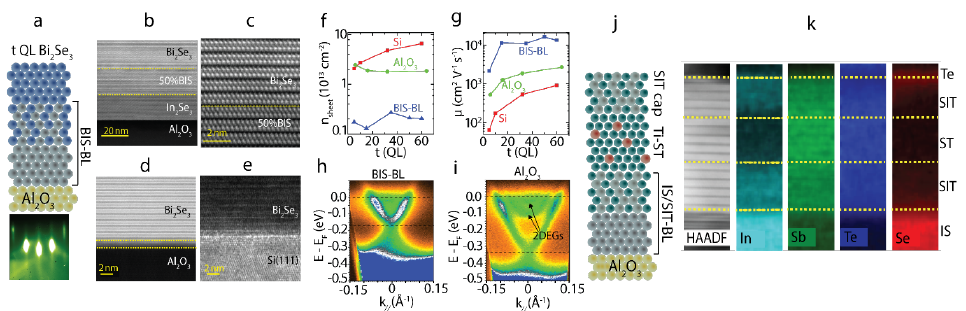
Se and Sb Te films with ultralow Fermi lev- Figure 1: Interface-engineered Bi 2 3 2 3 els . a, Cartoon of a buffer-layer-based Bi Se film where the buffer-layer (BIS-BL) is 2 3 composed of a 20 QL-thick In Se and a 20 QL-thick (Bi In ) Se (for growth de- 2 3 0.5 0.5 2 3 tails see ref. [ 57 ] ). The RHEED image of Bi Se film (bottom panel) shows high 2 3 quality 2D growth. b, and c, High angle annular dark-field scanning tunneling electron microscopy (HAADF-STEM) image of Bi Se grown on BIS-BL shows an 2 3 atomically-sharp interface between Bi Se and BIS-BL (50%BIS is a short form of 2 3 (Bi In ) Se ), while d, Bi Se grown directly on Al O has clearly disordered in- 0.5 0.5 2 3 2 3 2 3 terface. e, TEM image of Bi Se grown on Si(111) (from ref. [ 40 ] ) also shows a 2 3 hazy interface. Comparison of f, sheet carrier densities ( n ) and g, Hall mobilities sheet ( µ ) of Bi Se films grown on BIS-BL, Al O (0001) and Si (111) for different film 2 3 2 3 thicknesses. ARPES of Bi Se grown on h, BIS-BL shows the bulk-insulating nature 2 3 of the film with the surface Fermi level in the bulk gap and i, Al O (0001), where 2 3 the surface Fermi level is located above the bottom of the conduction band and the 2DEG originating from downward band bending is marked. (a), (b), (c), (d), (f), (g), (h), and (i) are adapted from ref. [ 57 ] . j, Schematic of the buffer-layer-based Sb Te 2 3 film structure. The buffer-layer (IS / SIT-BL) consists of 20 QL In Se and 15 QL- 2 3 thick (Sb In ) Te BL as a template for the successive layer of ultra-low carrier 0.65 0.35 2 3 density Ti-doped Sb Te . The film is capped by 15 QL (Sb In ) Te providing 2 3 0.65 0.35 2 3 a symmetric condition for top and bottom surfaces of the Sb Te film. k, The first 2 3 / 5 QL (Sb / 5 QL Sb / 5 QL panel shows HAADF-STEM for In Se In ) Te Te 2 3 0.65 0.35 2 3 2 3 (Sb In ) Te with an additional 10 nm Te capping for further protection against 0.65 0.35 2 3 STEM sample preparation processes. Yellow dashed lines mark each interface. The rightward four panels show the elemental mapping electron dispersive X-ray spec- troscopy (EDS) images for In (light blue), Sb (green), Te (dark blue), and Se (red). If a specific element is present in a layer, then the corresponding color appears boldly in that section; in its absence, the layer appears dark. Figures (j) and (k) are adapted from ref. [ 60